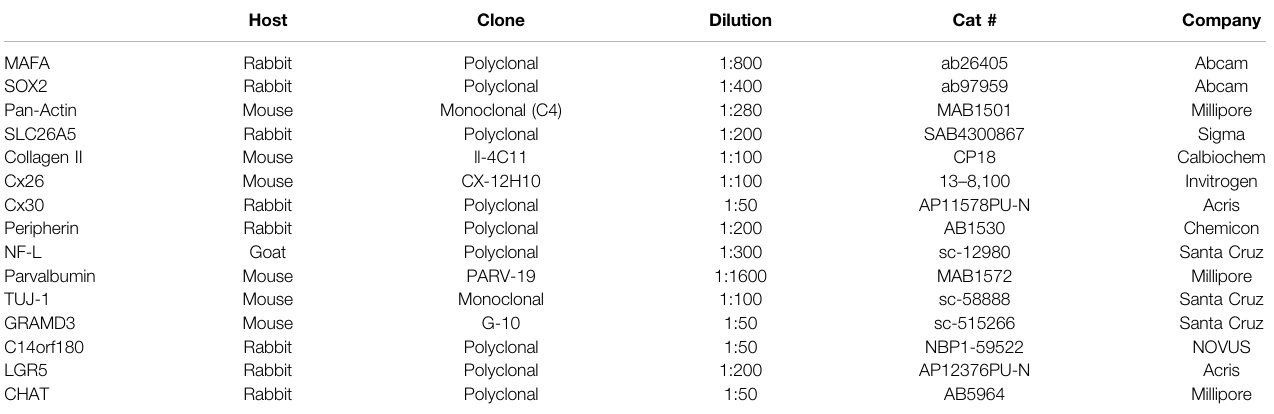
TABLE 1 | Antibodies used in the present